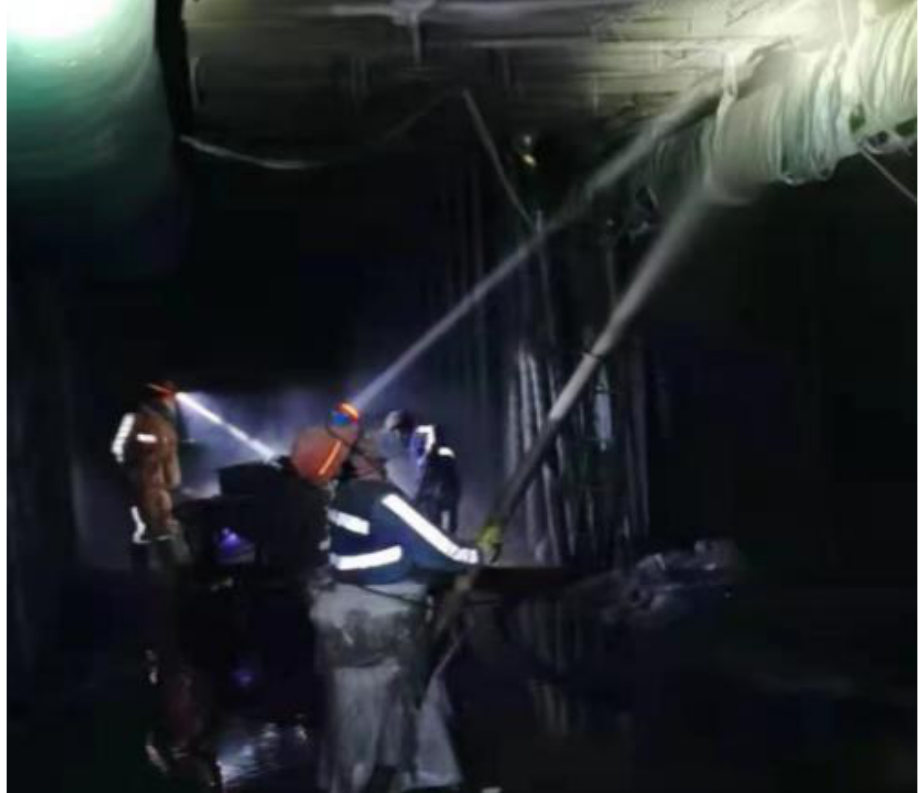
Figure 6. Site map.